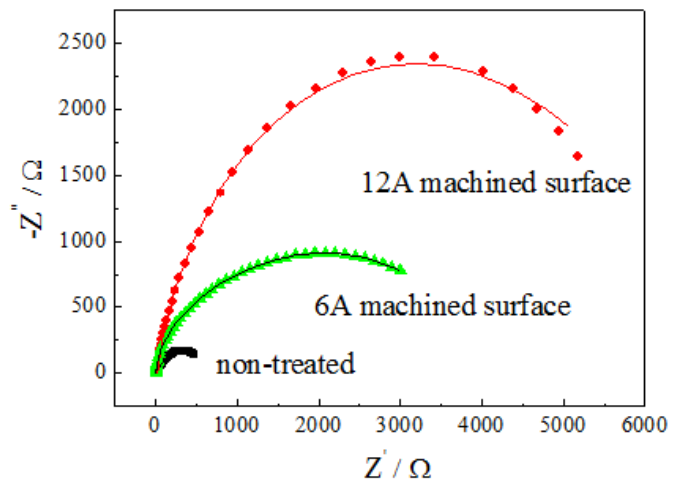
Figure 9. Nyquist impedance diagrams and the fitted results of 6A and 12A machined surfaces along with the reference non-treated surface in 3.5 wt.% NaCl aqueous solution at 25 °C. The symbols are the experimental data whereas the continuous lines represent the fitted spectra.